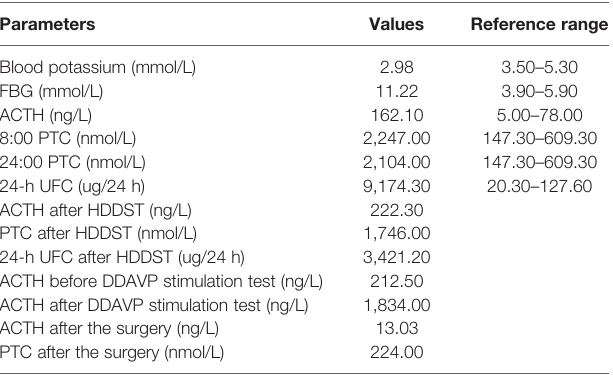
FBG, fasting blood glucose; ACTH, adrenocorticotrophic hormone; PTC, plasma total cortisol; UFC, urine-free cortisol; HDDST, high-dose dexamethasone suppression test; DDAVP,